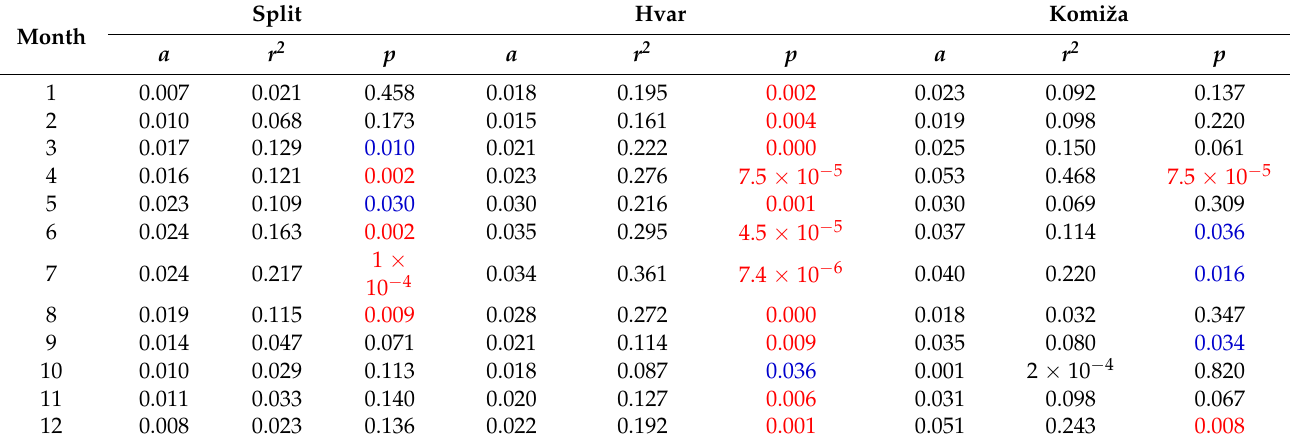
Table 6. The slope of the linear equation, a, squared values of the linear correlation coefficient, r 2 , and M–K probability values, p , calculated from the time series of the mean monthly SST. M–K p values 0.01 < p < 0.05 are highlighted in blue, and p < 0.01 in